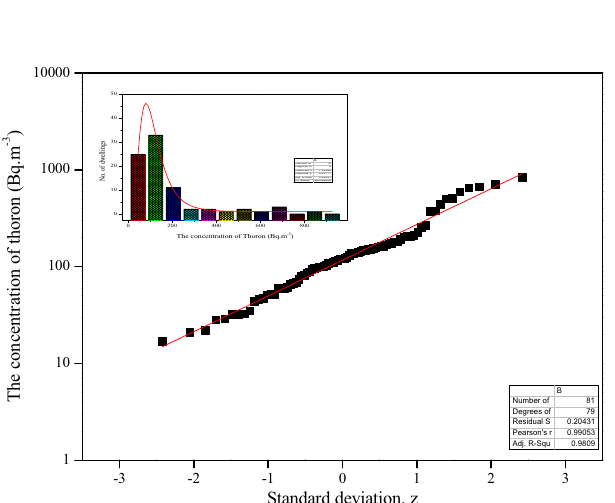
Figure 1. Distribution of the activity concentration of 222 Rn. Histogram (inset).